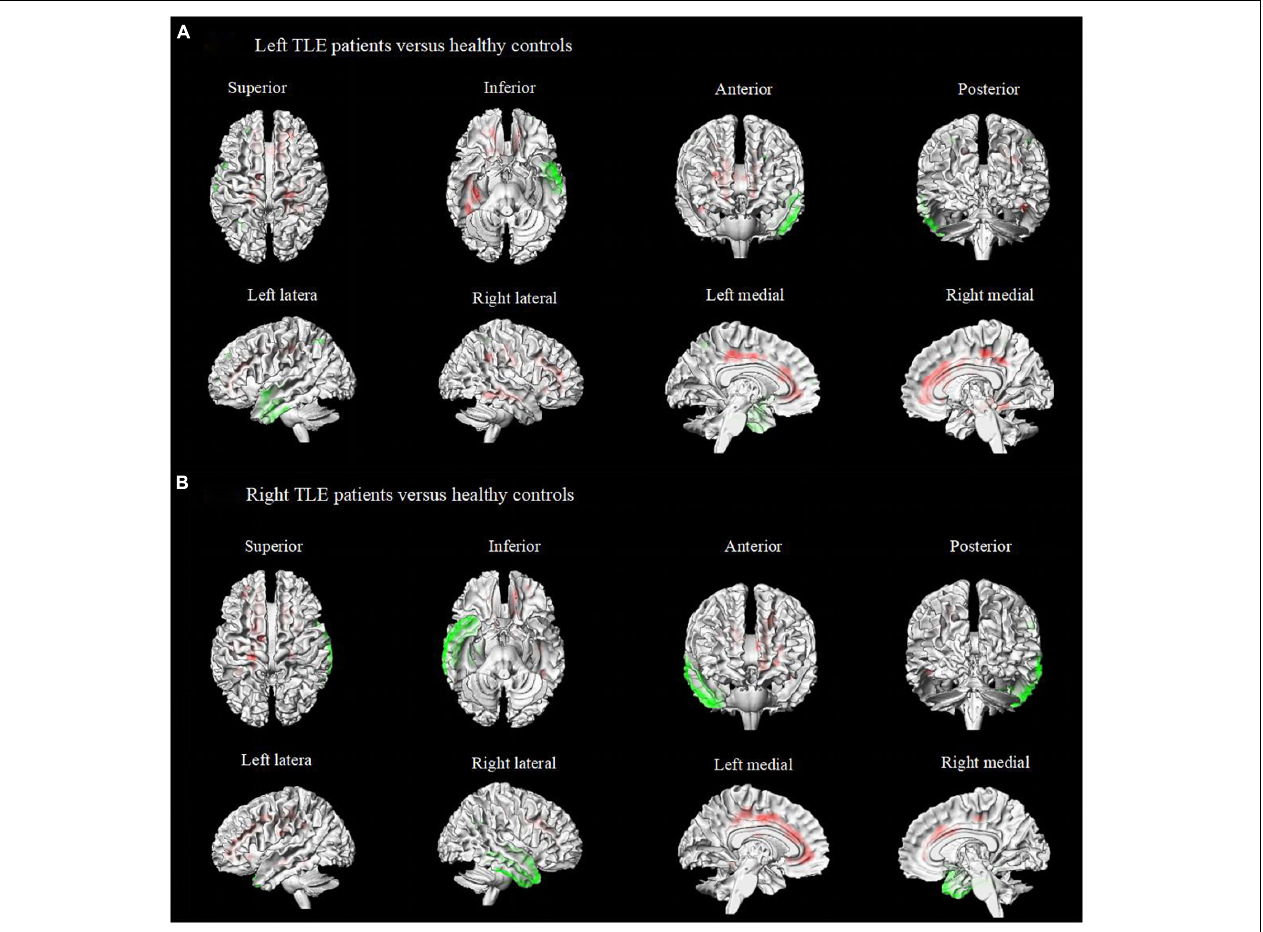
FIGURE 3 | Metabolic features in patients with right and left temporal lobe epilepsy with impaired awareness seizures. Comparison of patients with differed in right and left TLE-IAS patients versus healthy controls ( N = 60) (FWE corrected p < 0.05 with cluster thresholding, k = 20 voxels). Voxels with significantly low uptake are shown in green and voxels with significantly high uptake are shown in red. (A) Left TLE-IAS patients versus healthy controls, (B) Right TLE-IAS patients versus healthy controls. Patients from both laterality groups consistently displayed marked hypermetabolism in the contralateral temporal lobe, frontoparietal regions, the regions of the cingulate gyrus, along with hypometabolism in the ipsilateral temporal lobe, bilateral frontal lobe, insular lobe, and parietal lobe. The heat map depicts t -values. Coordinate and regional details are presented in Table 2 . TLE-IAS, temporal lobe epilepsy with impaired awareness